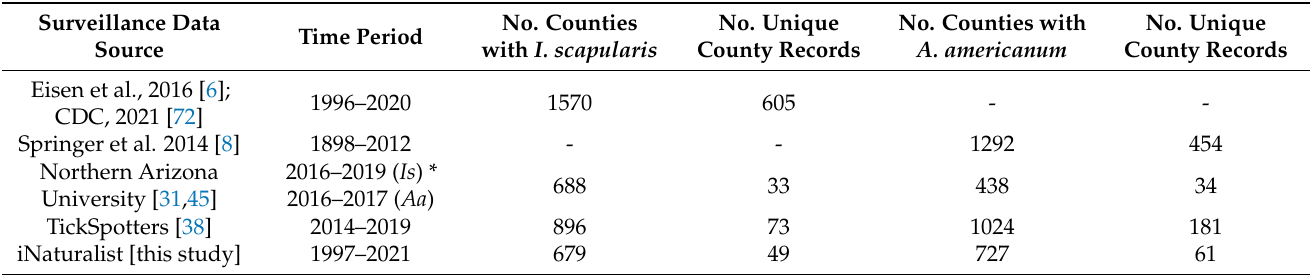
Table 2. Comparison of county-level occurrence data of I. scapularis and A. americanum in US states included in the study region from various US tick surveillance data sources. Data are available in Table S3.